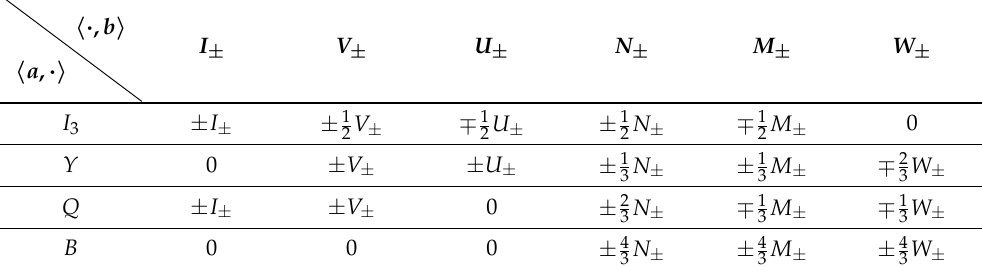
Table 1. Commutators of operators (14).